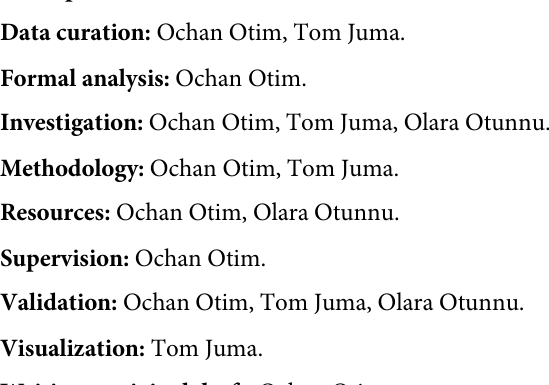
S1 Table. Mean metal concentrations ( ± standard deviation, μ g/L) of duplicate measure- ments by ICP-MS. Values greater than 10 μ g/L in bold. (a) Sachet samples. MDL: method detection limit. Brand identities and definitions are provided in Table 1. (TGL). (b) Control samples ( μ g/L). S2 Table. Target hazard quotient ( THQ = ADI/RfD ) values for each metal detected in each alcohol brand used to determine the hazard index ( HI ). The percent contribution of copper (Cu) to the HI for AWE, BOL, NSB and TEB (the Lira-Lira drinks) shown in bold numerals are 93%, 75%, 74% and 97%, respectively. Note also that Cu contributes 45% to TLG’s HI , the reference Scotch